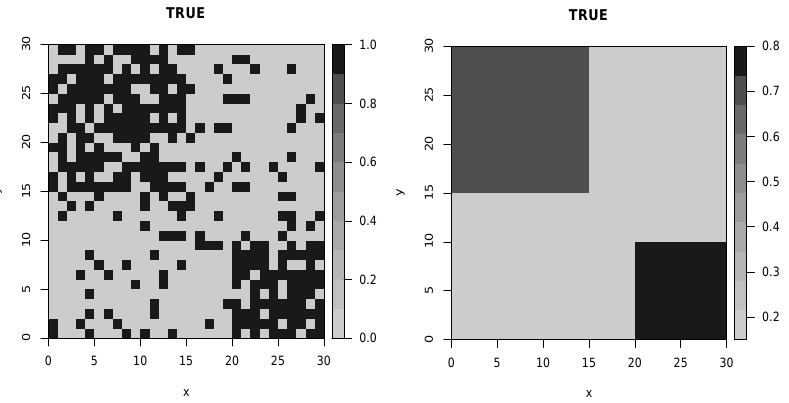
Figure 6. Domains as determined by the true profile (Example 2).